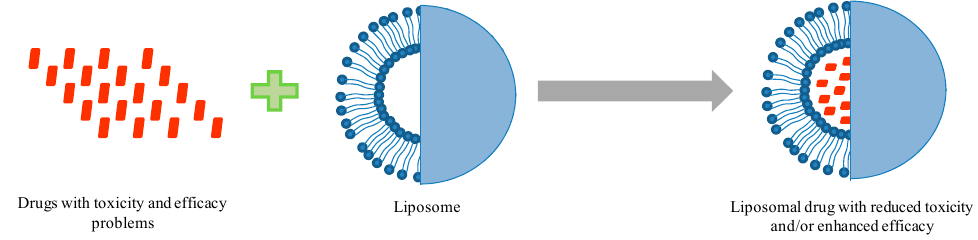
Figure 1. Schematic representation showing the advantages of formulating drugs in liposomes.